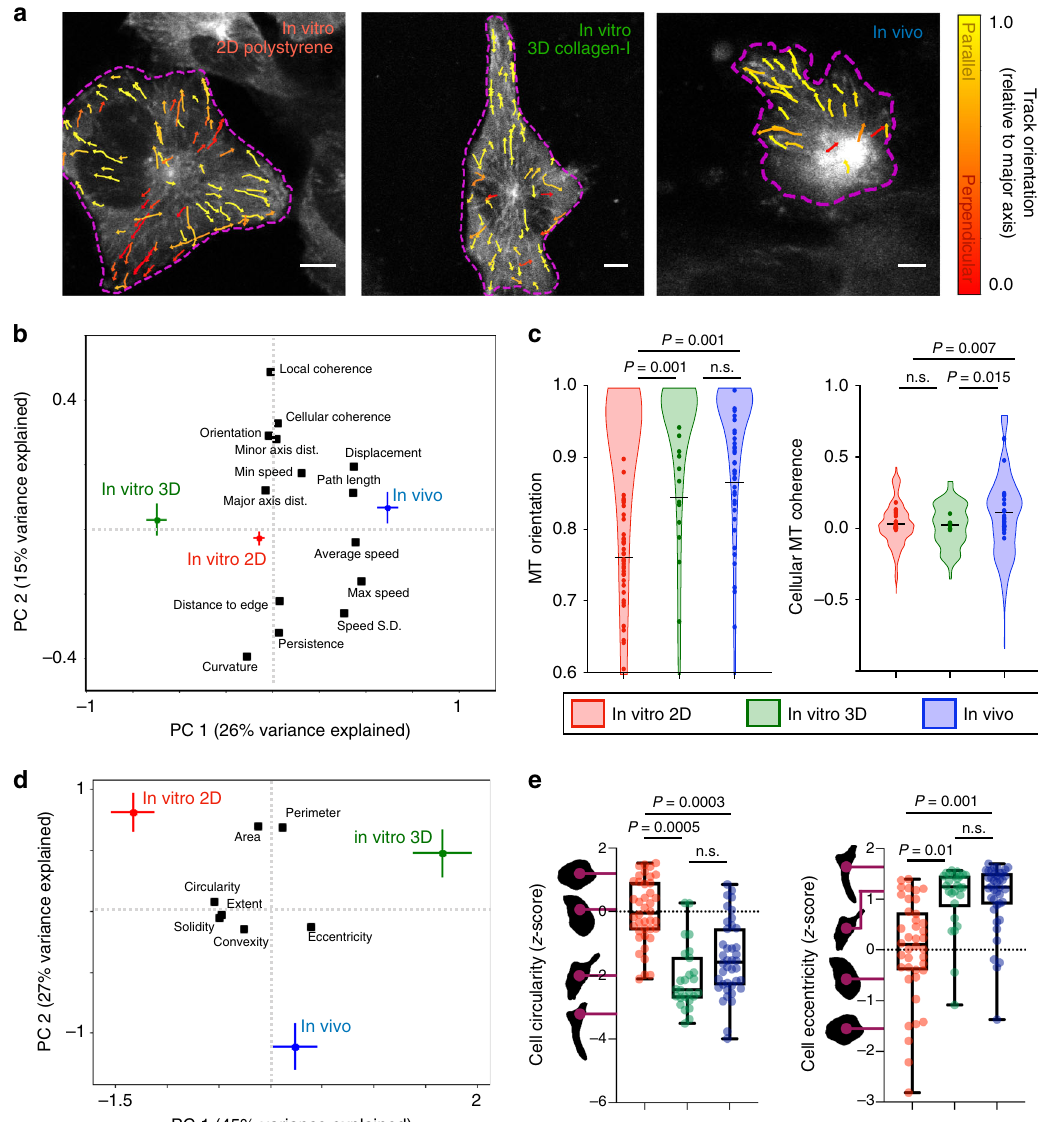
Fig. 2 Coherent in vivo MT dynamics are not fully reproduced by 3D collagen in vitro cultures. a Representative confocal images of HT1080-EB3- mApple cells grown as indicated, with tracks pseudo-colored according to MT orientation along the major length axis of the cell (scale bar = 5 μ m; n = 85 cells across n ≥ 2 in vitro replicates and n = 4 tumors). b MT features were analyzed by principal components analysis (PCA), shown according to average condition score (±s.e.m.) and variable loadings (black squares; n = 5794 tracks, middle 95% for all features). c Violin plots show single-track distributions for orientation and cellular coherence (bar denotes median, cell averages overlaid as individual data points; *two-tailed permutation test; n = 9448 total tracks from 85 cells). d PCA captures covariation between cellular shape features (loadings, black) across imaging conditions (scores ±s.e.m.; n = 106 cells). e Single-cell distributions of shape features, matching d (* two-tailed t test; n = 106 cells; box plot bars represent the minimum, 25%tile, median, 75%tile, and maximum values ) . Source data are provided as a source data fi